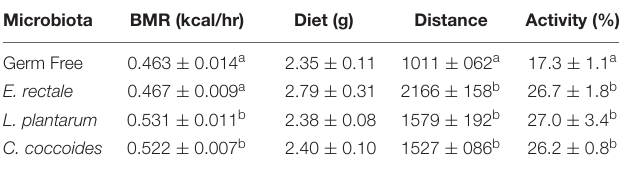
TABLE 2 | The metabolic phenotype indexes in indicated gnotobiotic